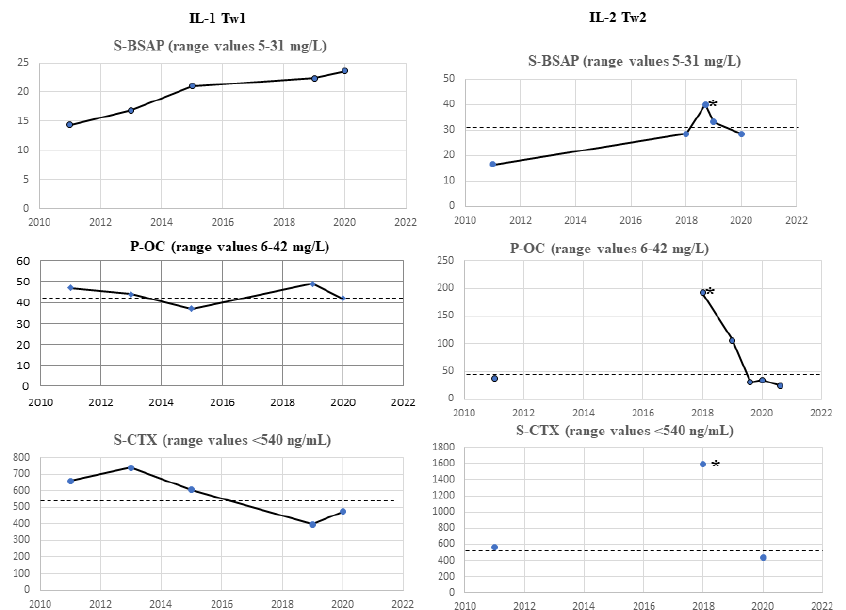
Figure 6. BTMs trend over time (U-NTX is not described here, which is instead described in Table 2). The dashed line in the graphs represents the upper limit of the range for each parameter. On the right side of each figure are the respective units of measurement, indicated in the parenthesis next to each BTM. The line below each graph shows the year in which the relevant biochemical assessments were carried out. The *symbol indicates the start of amino-bisphosphonate therapy (stopped at the end of 2020).